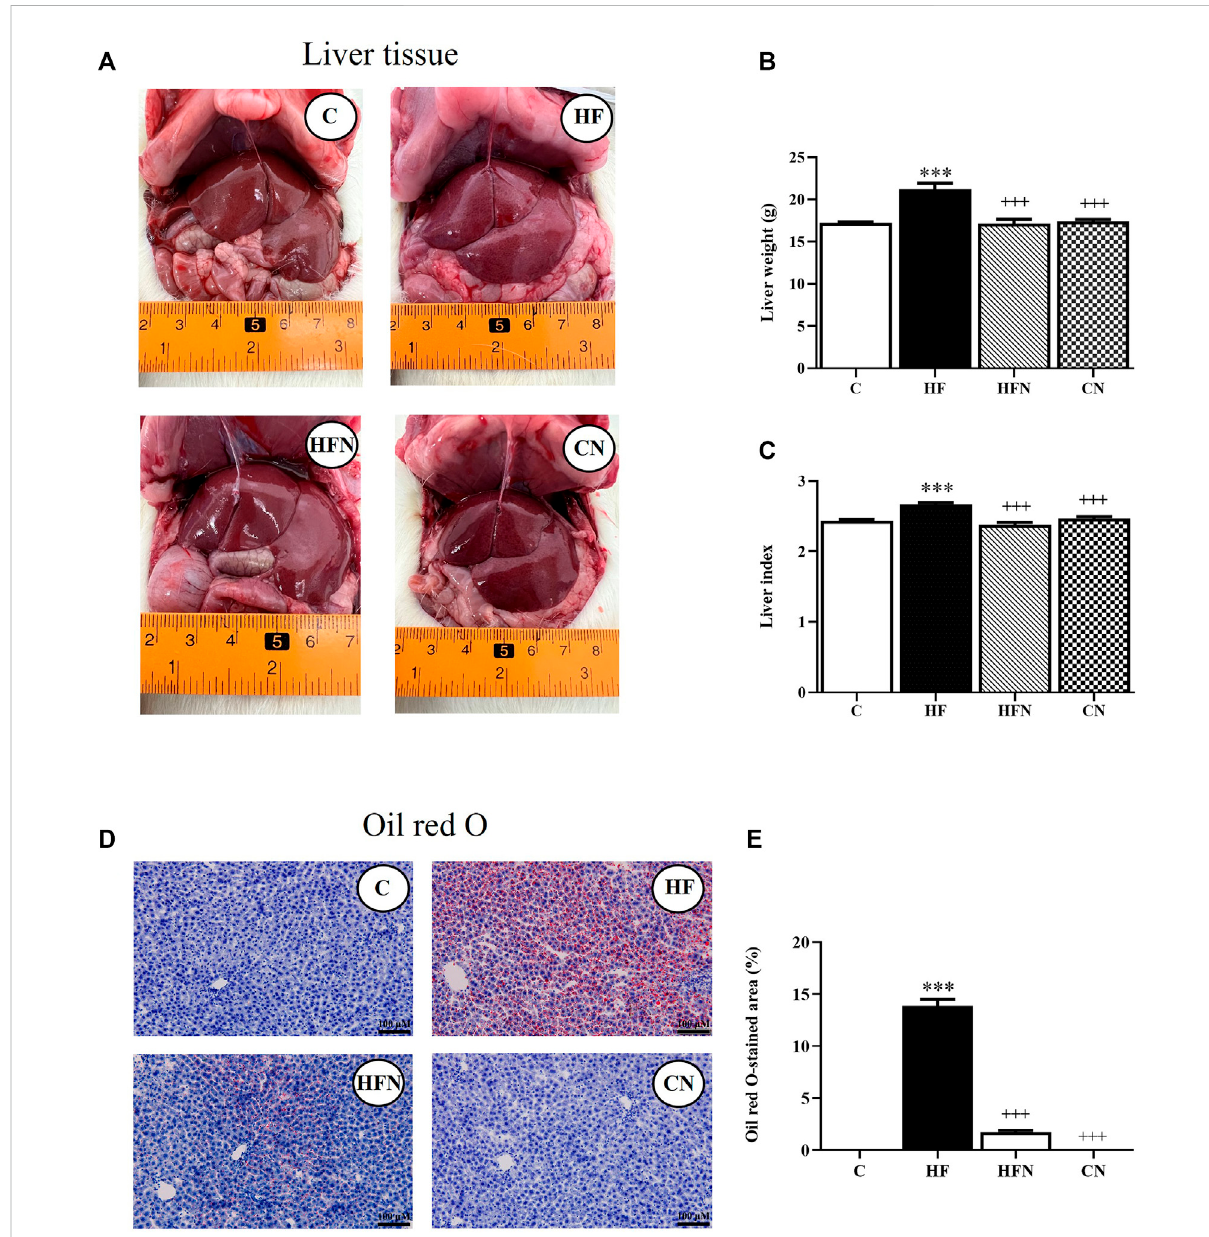
FIGURE 1 Theeffectsofnaringinonhepaticlipidaccumulation. (A) Macroscopicappearance, (B) liverweight, (C) liverindex, (D) OilRedOstainingoflivers (magni fi cation ×20) and (E) the percentage of Oil Red O-stained liver section in control rats (C), fructose-fed rats (HF), fructose-fed rats treated with naringin at 100 mg/kg (HFN) and control rats treated with naringin at 100 mg/kg (CN). Liver index was calculated using the formula [(liver weight/ body weight)*100]. The Oil Red O staining shows as red-orange, de fi ning the lipid deposition area, and hematoxylin staining in blue indicated thecellnucleus.Theresultsshownarepresentedasthemean±standarderrorofthemean(n=5pergroup).*** p < 0.001comparedwiththecontrol group; +++ p < 0.001 compared with the HF